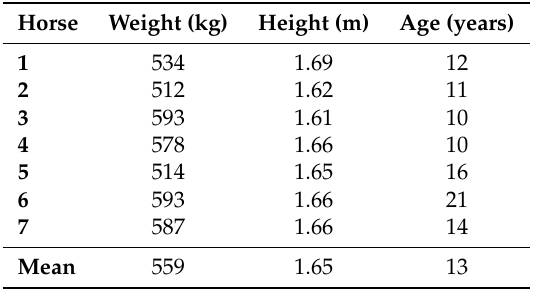
Table 1. Properties of the horses involved in the experiments.